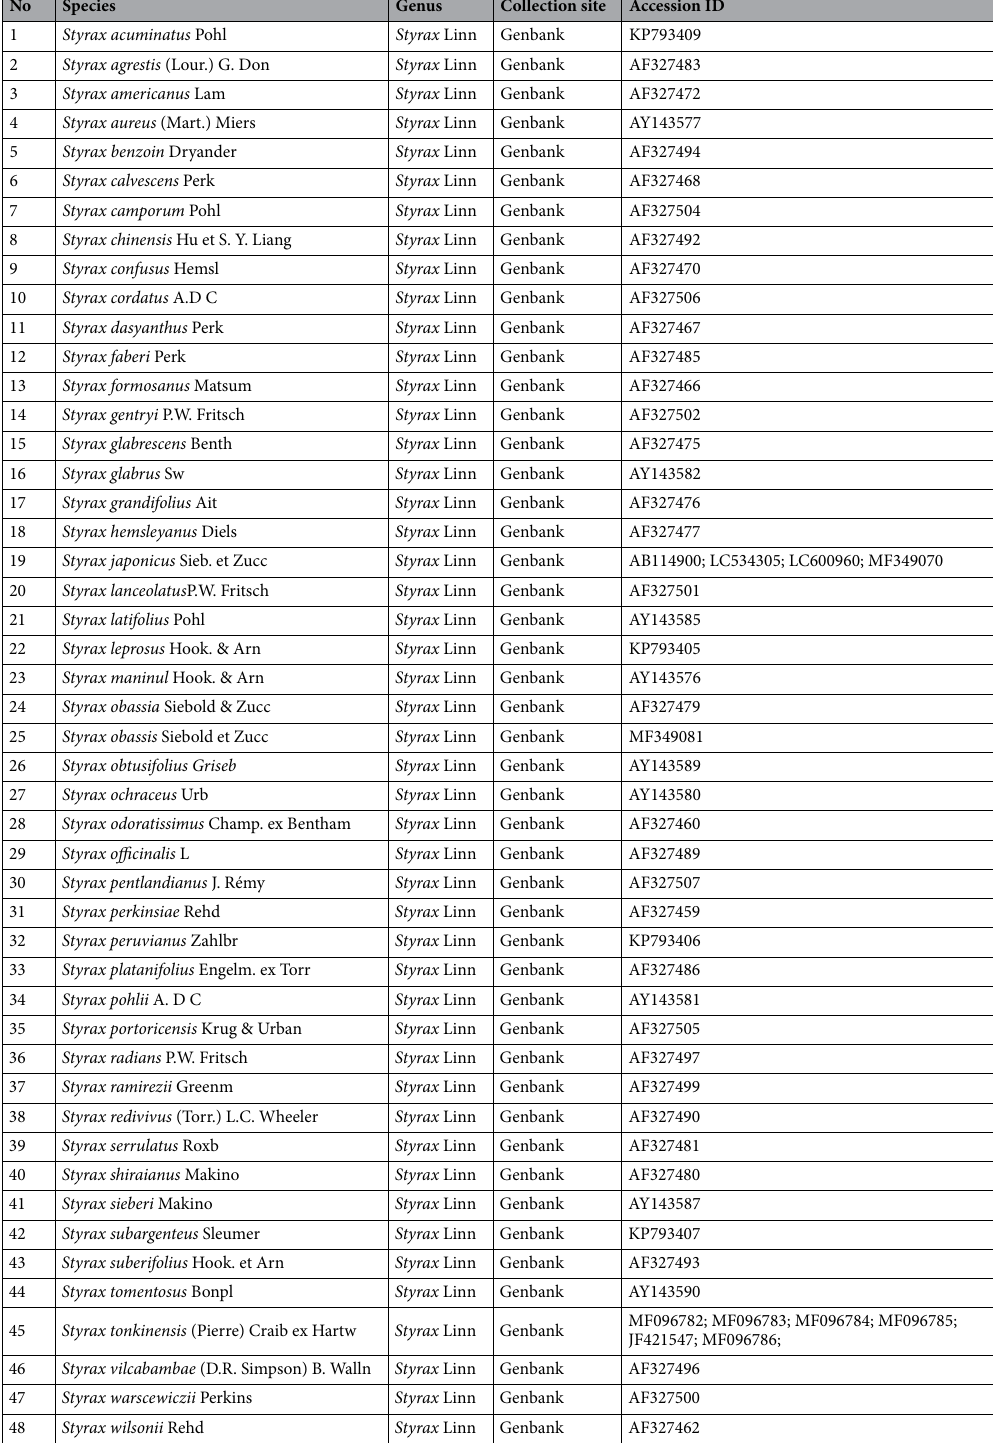
Table 7. ITS2 sequences of species of the genus Styrax Linn. in